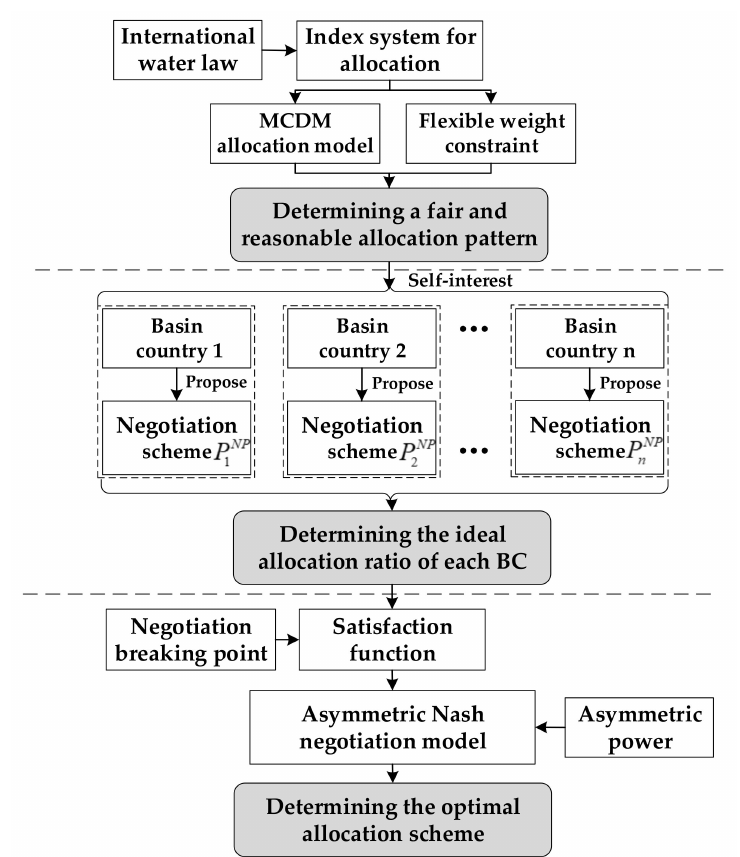
Figure 1. Logical structure of water resources allocation in trans-boundary river